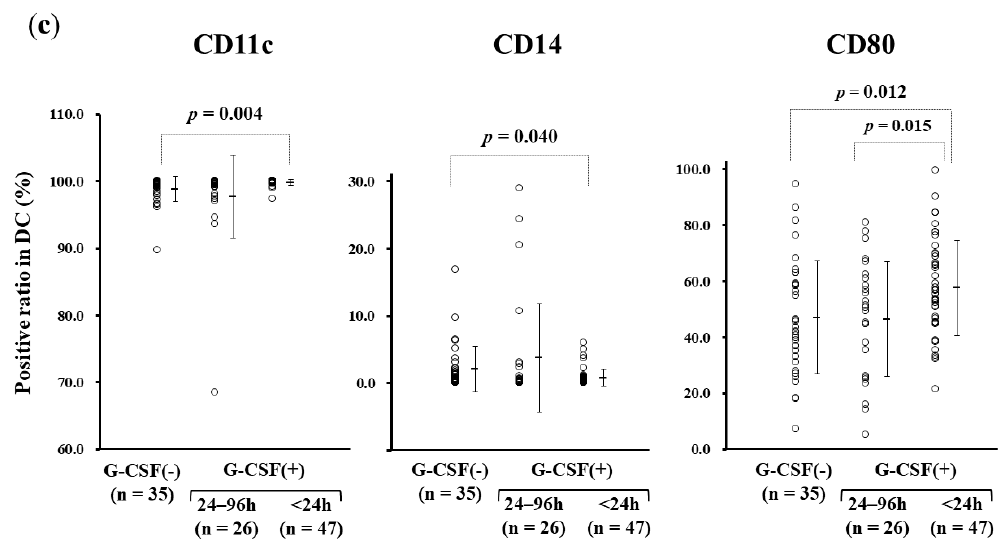
Figure 3. E ff ect of recombinant human granulocyte colony-stimulating factor (rhG-CSF) on the number of monocytes and the monocyte-derived dendritic cell (DC) yield. ( a ) The numbers of both peripheral and apheresed monocytes were higher in G-CSF-treated groups than in the non-G-CSF group. The number of peripheral blood monocytes (/µL) were as follows: G-CSF( − ), 436.7 ± 215.6; 24–96 h, 618.3 ± 310.5; and <24 h, 618.9 ± 303.0 (mean ± SD). The total numbers of apheresis monocytes (×10 7 ) were as follows: G-CSF( − ), 111.3 ± 69.9; 24–96 h, 148.7 ± 74.8; and <24 h, 145.5 ± 73.0 (mean ± SD). ( b ) The DC yield and the ratio of DCs to apheresed monocytes (DC/monocyte-ratio) were significantly higher in the 24-h than in the 24–96-h G-CSF-treated and the non-G-CSF-treated groups. The total number of DC (×10 7 ) were as follows: G-CSF( − ), 14.4 ± 8.0; 24–96 h, 17.7 ± 7.9; and <24 h, 25.8 ± 8.6 (mean ± SD). DC/monocyte-ratio (%) were G-CSF( − ), 15.2 ± 6.9; 24–96 h, 14.1 ± 7.5; and <24 h, 20.0 ± 7.5 (mean ± SD). ( c ) Effect of rhG-CSF on the monocyte-derived DC phenotype. The intensity of the yielded DCs with CD11c and CD80 was increased, while CD14 expression occurred to a lower degree in the 24-h compared with the 24–96-h G-CSF-treated and the non-treated groups. Positive ratio (%) of CD11c were 98.9 ± 1.9, 97.7 ± 6.2, and 99.9 ± 0.8 in groups G-CSF( − ), 24–96 h, and <24 h (mean ± SD), respectively. The ratio of CD14 + was 2.0 ± 3.4, 3.7 ± 8.1, and 0.8 ± 1.3, respectively, and that of CD80 + was 47.1 ± 20.2, 46.5 ± 20.5, and 57.6 ± 17.0, respectively.